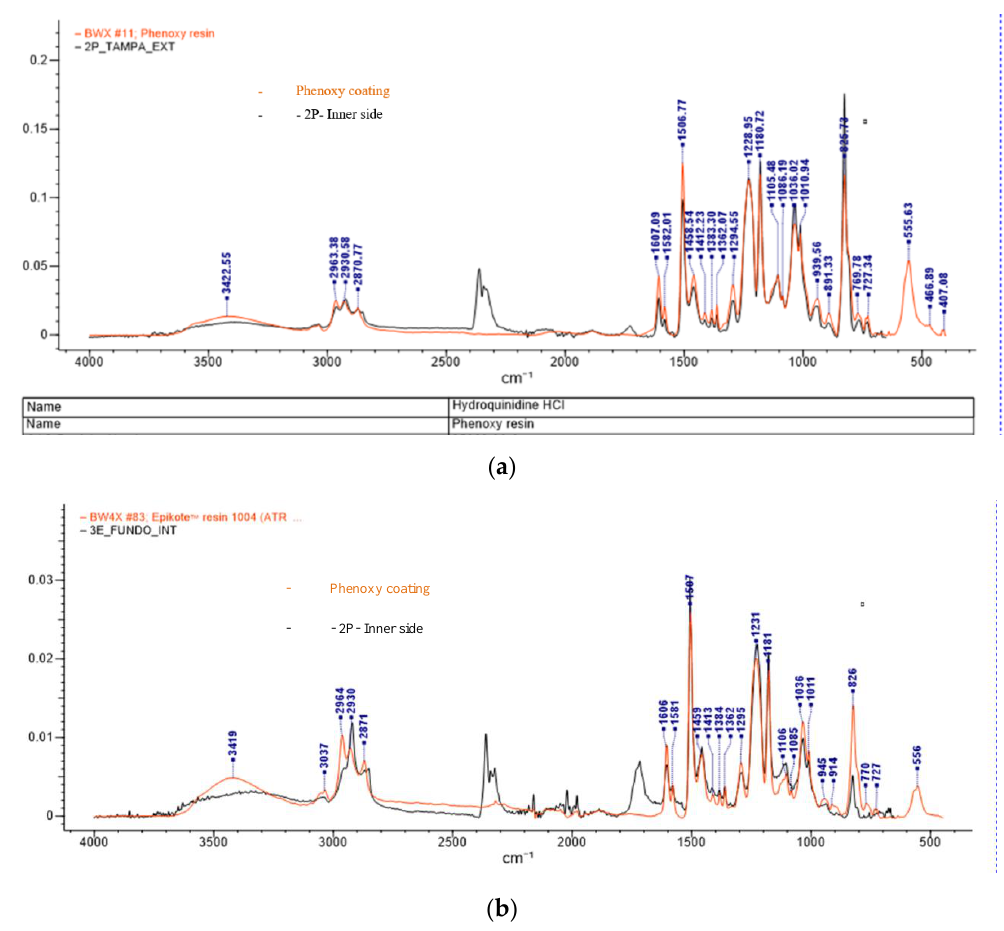
Figure 5. ATR-FTIR spectra of the: ( a ) phenoxy coating in the inner side of the sample 2P; ( b ) polyester coating in the inner bottom of the sample 3S.